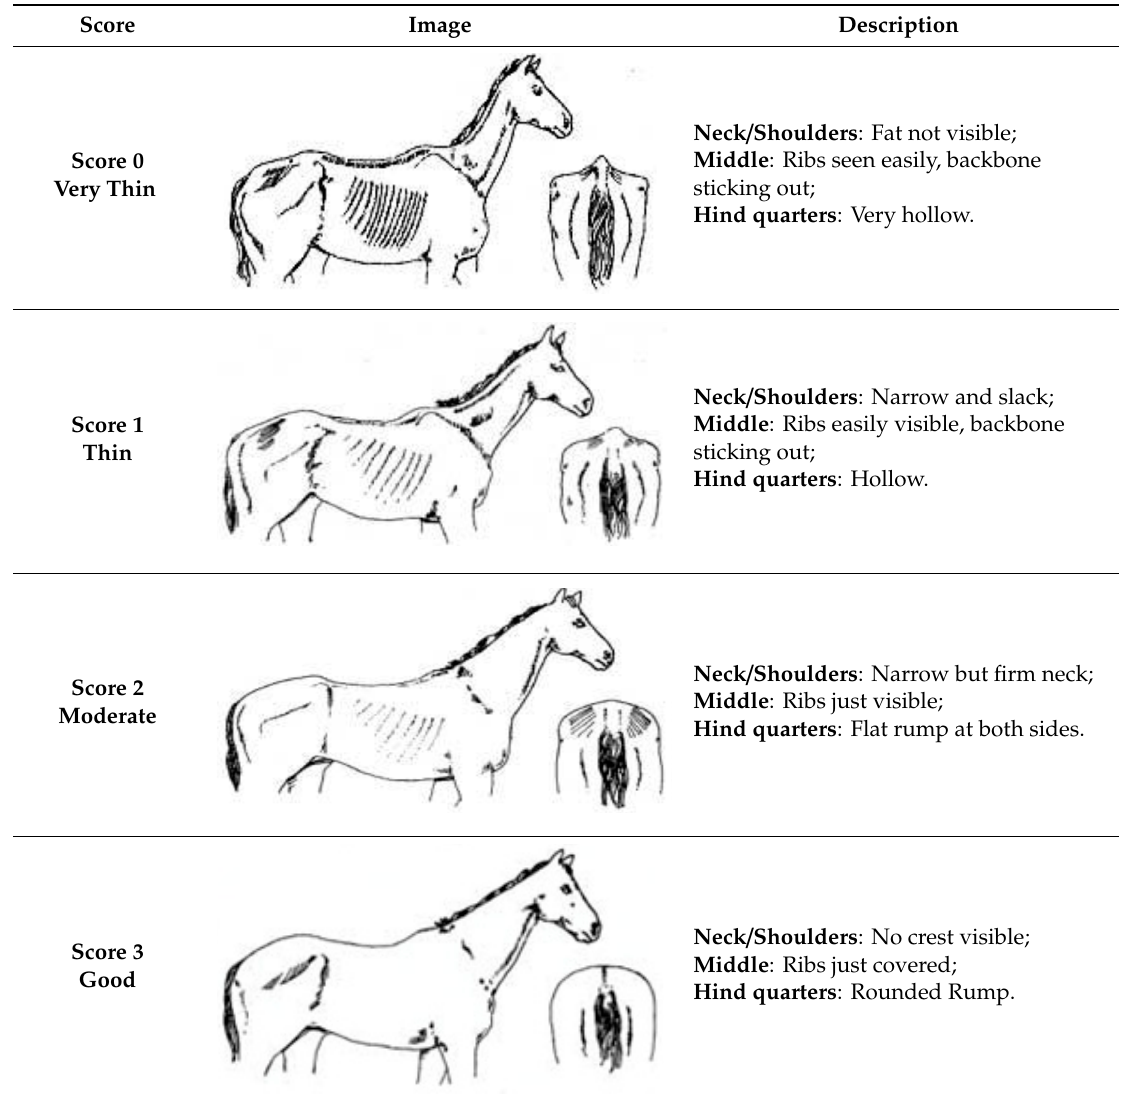
Table 2. Revised descriptors of the BCS chart (adapted from Carroll C.L. and Huntington P.J. [31]).